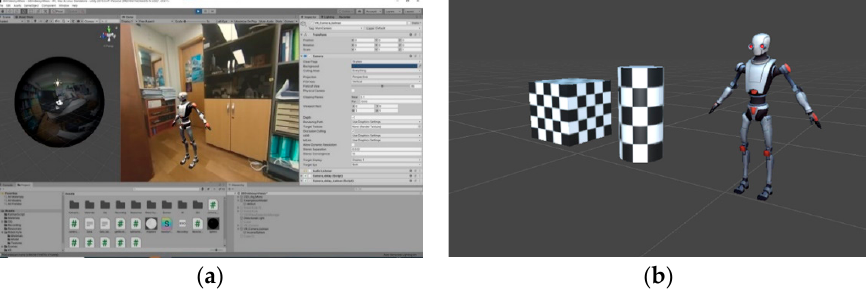
Figure 6. Pre-visualization system: ( a ) pre-visualization Unity scene and ( b ) simple 3D object.